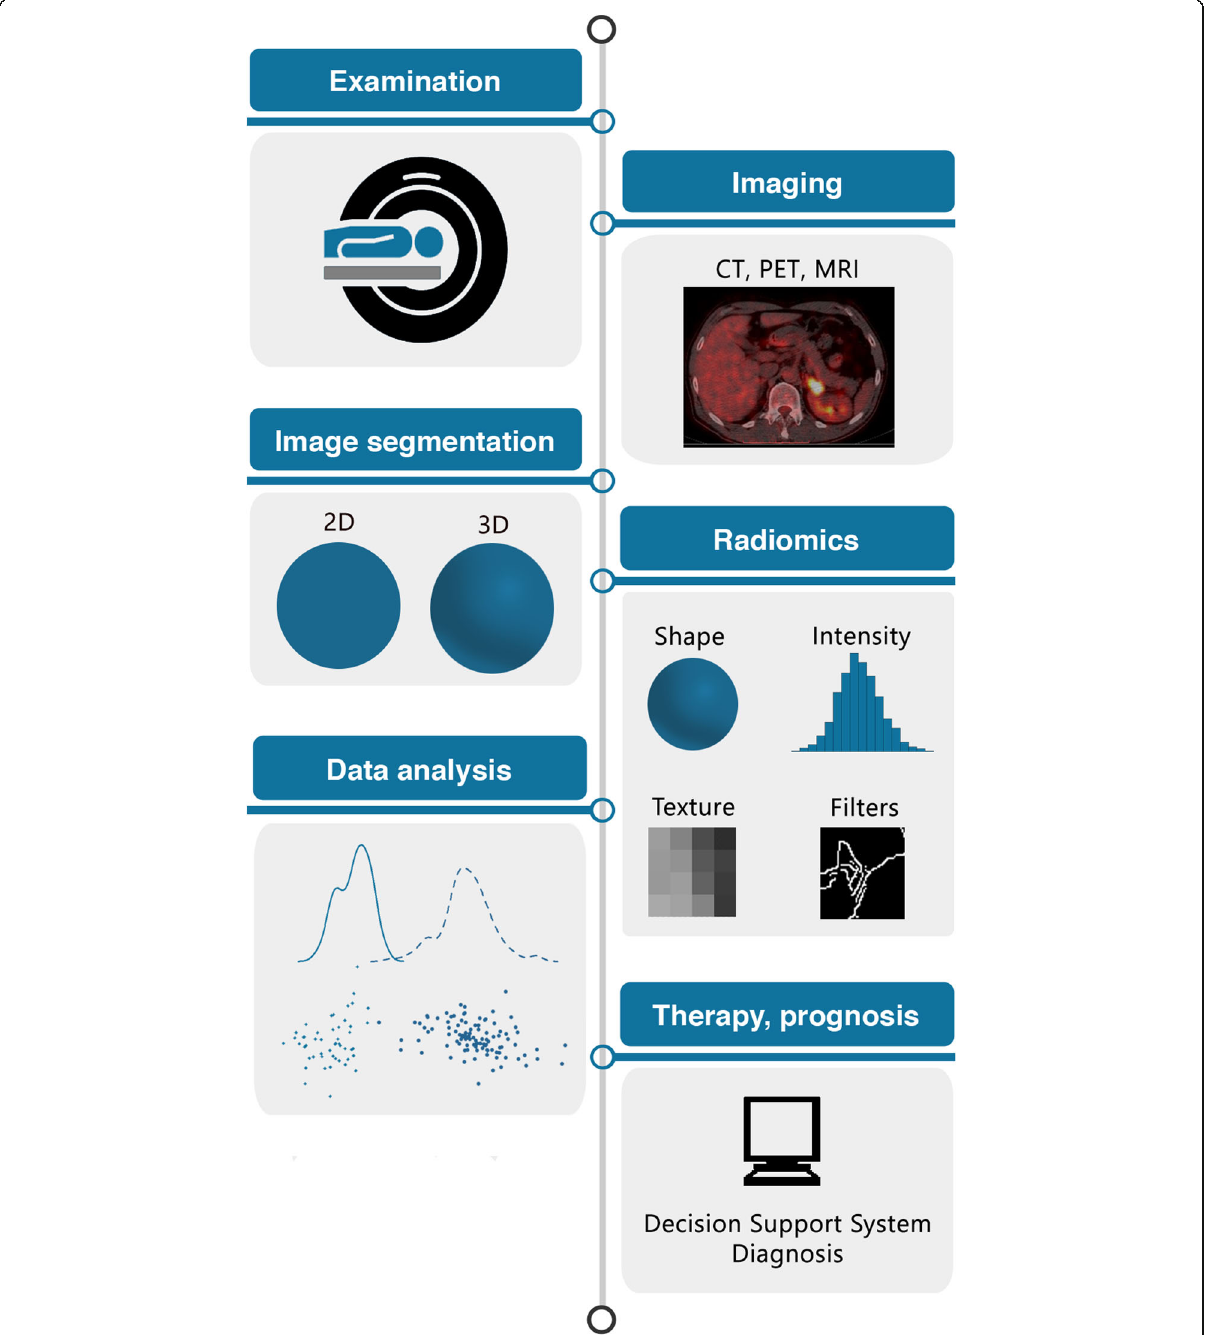
Fig. 1 The radiomics workflow. Schematic illustration of the patient journey including image acquisition, analysis utilizing radiomics, and derived patient-specific therapy and prognosis. After image acquisition and segmentation, radiomic features are extracted. High-level statistical modeling involving machine learning is applied for disease classification, patient clustering, and individual risk